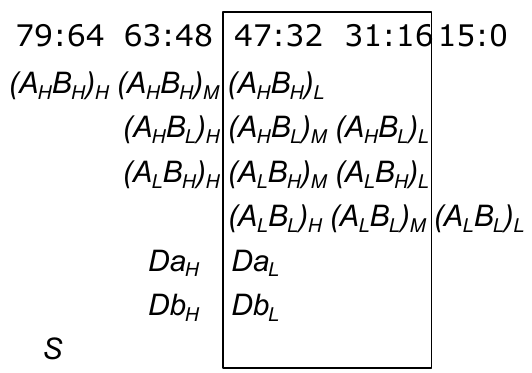
Figure 3. Components of matrix multiplication of 32-bit signed integers via matrix multiplication of 16-bit signed integers.